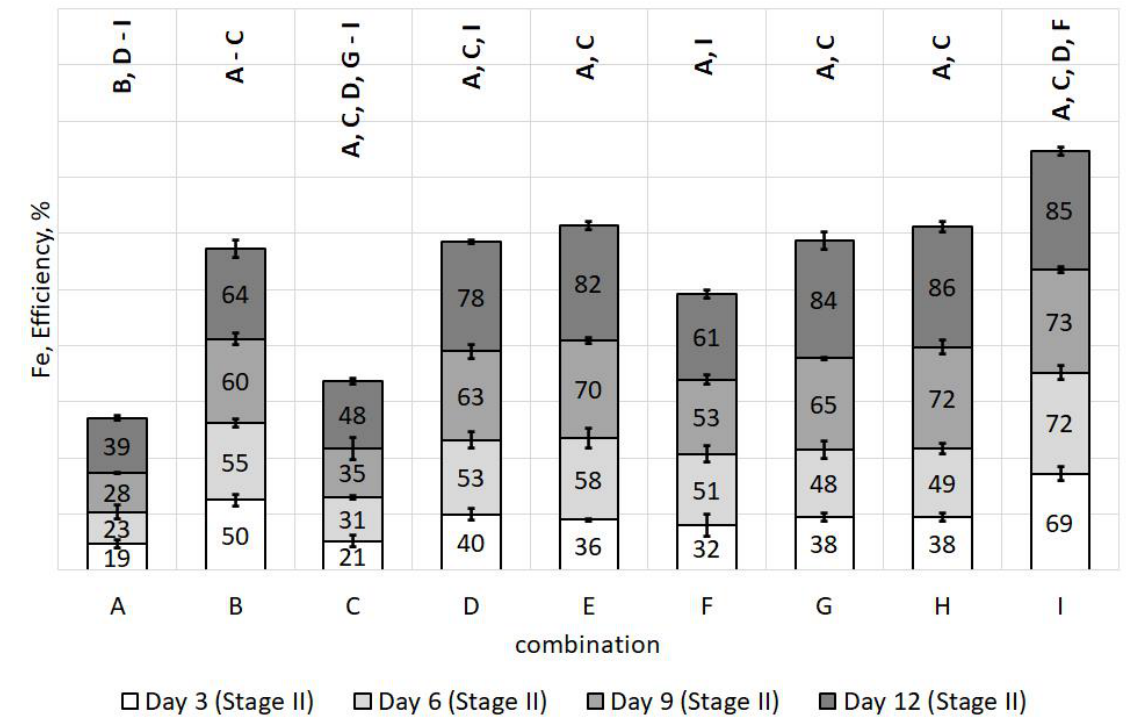
Figure 14. Effectiveness of Fe release to the dissolved fraction of leachate (Stage II).